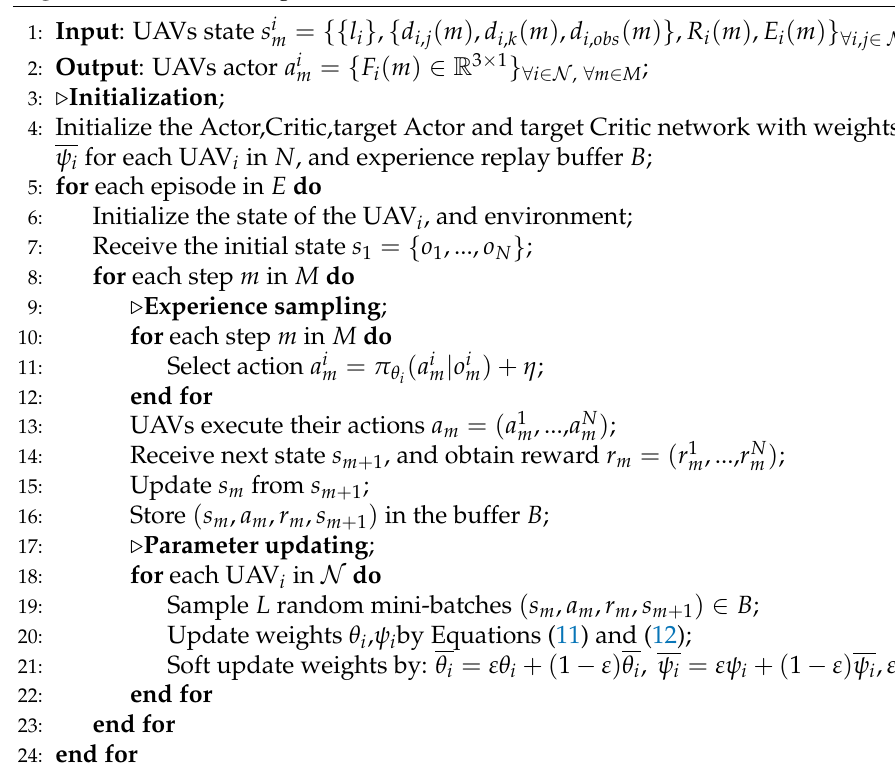
Algorithm 1 DSAAC